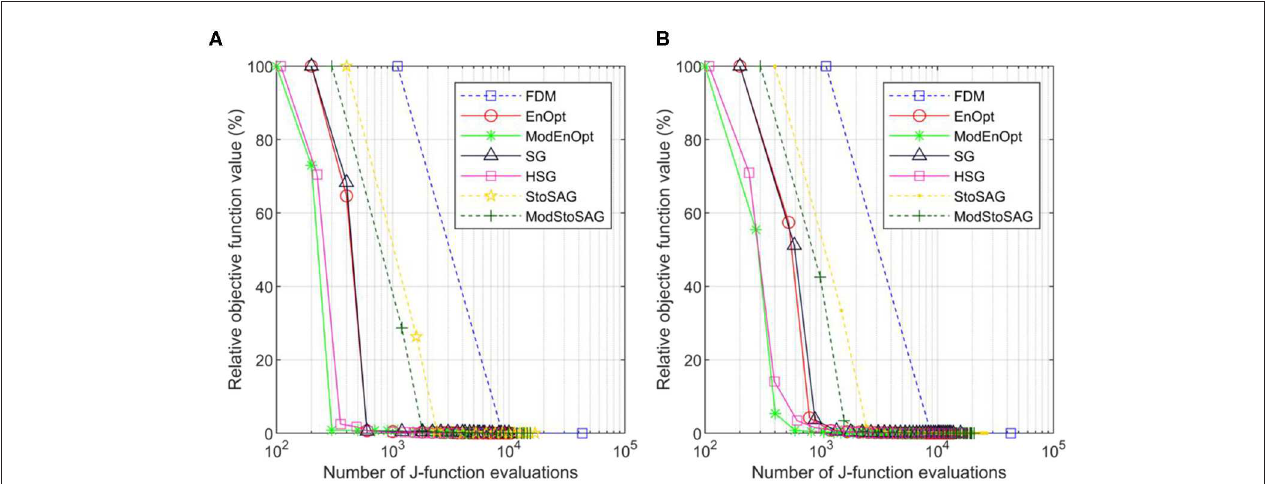
FIGURE 1 | Plot of numbers of J -function evaluations and relative objective function values of the seven gradient methods for σ m = 0.01. (A) Relative objective function value is a percentage of the initial objective function value. Symbols represent iterations, and the x -axis is the total number of function evaluations. (B) Shows the average relative objective function values and the average total number of function evaluations of 100 optimization runs.